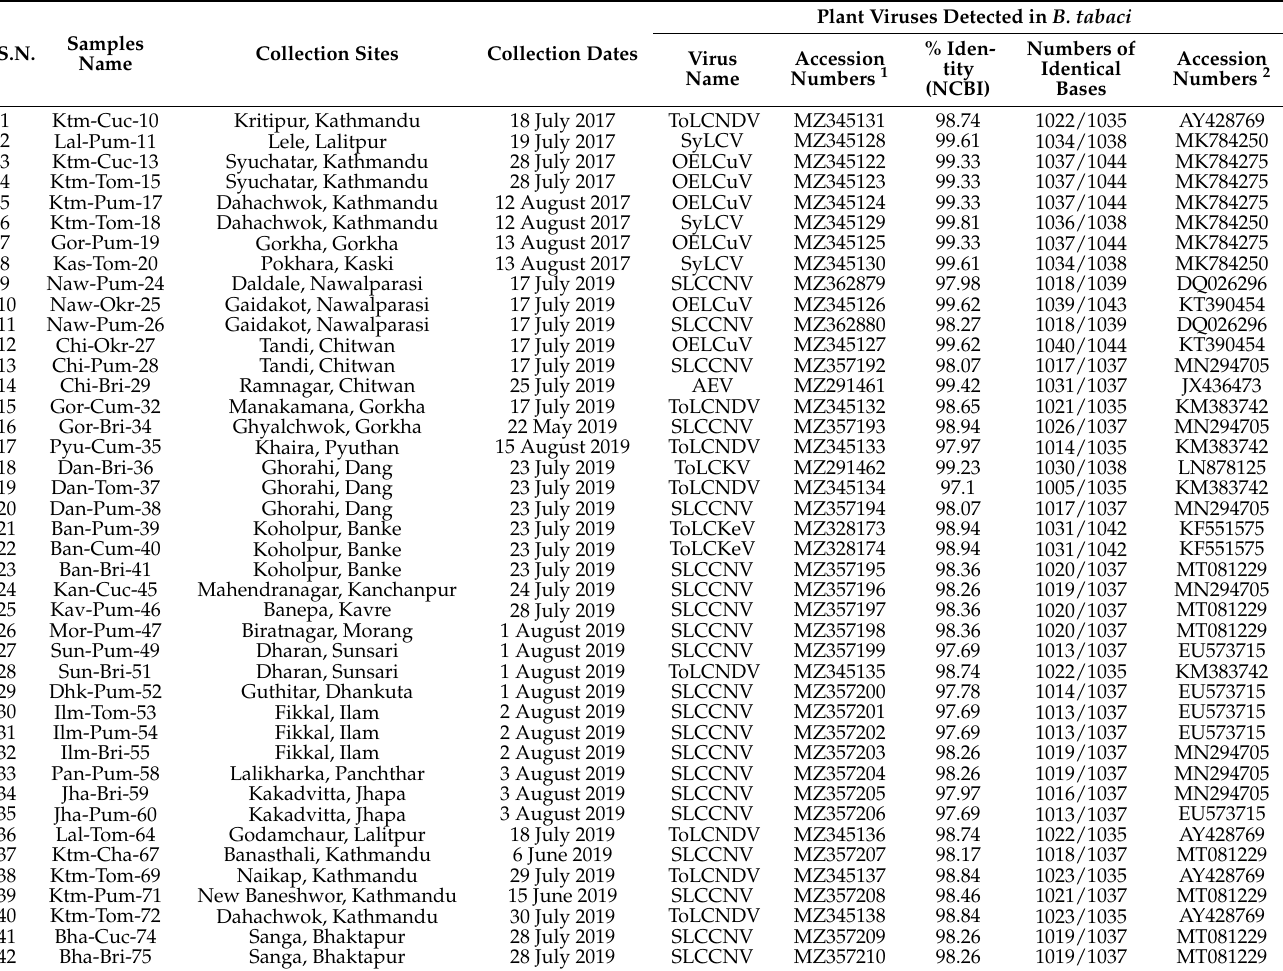
Table 1. Details of Bemisia tabaci samples were collected from different regions in Nepal along with the most identical sequences information from NCBI including their percent identities, numbers of identical bases and accession numbers.